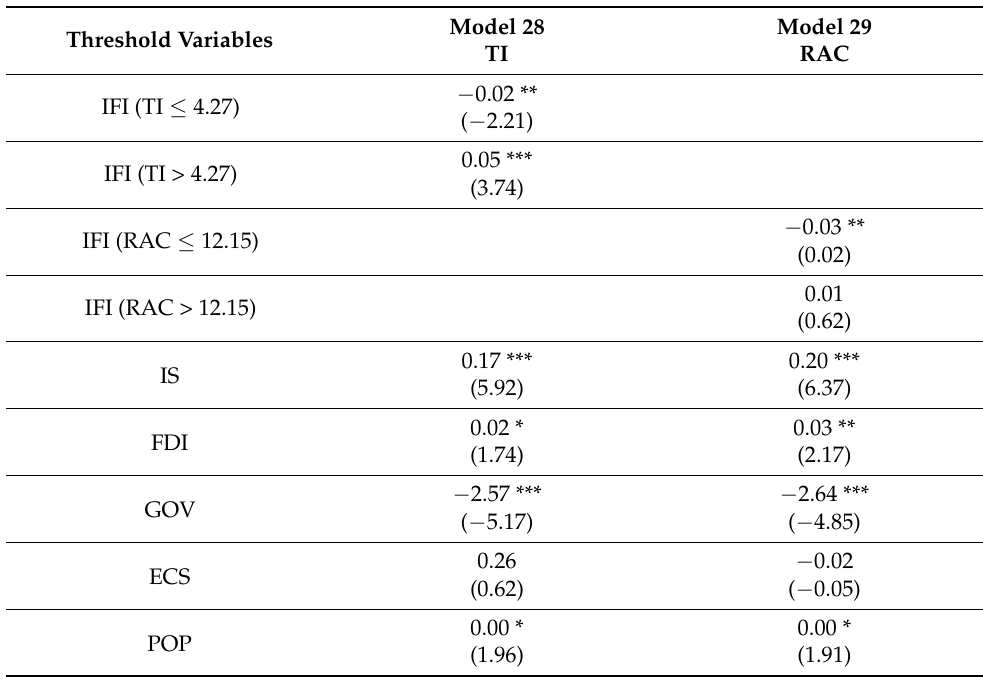
Table 13. Threshold panel